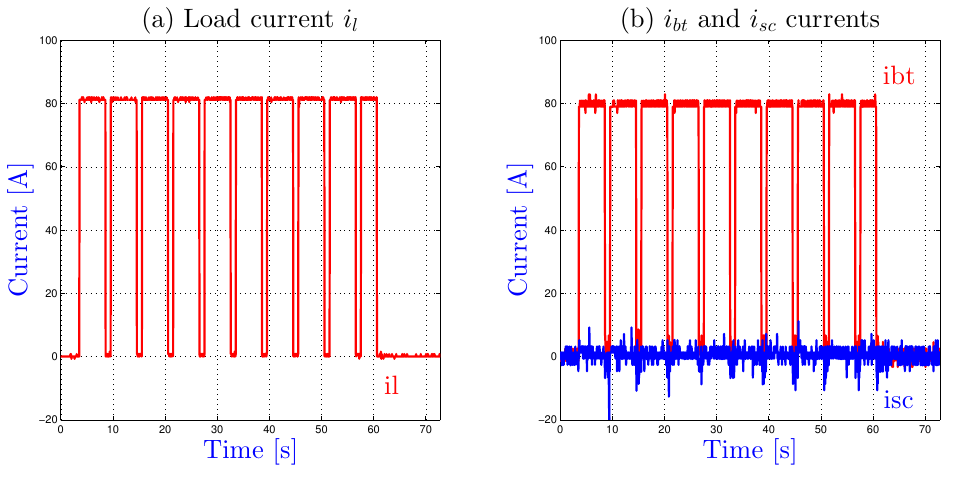
Figure 10. Experimental results during nominal condition - state is equal to